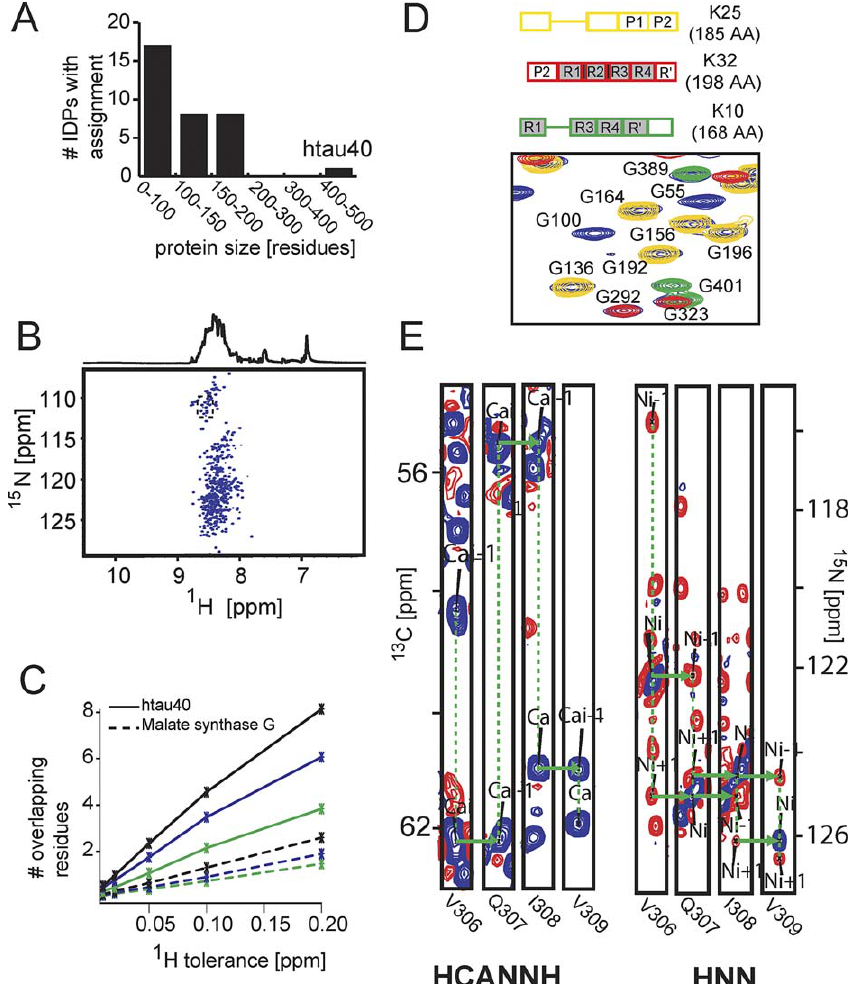
Figure 2. 441-Residue Tau at Single-Residue Resolution (A) Number of intrinsically disordered proteins with NMR backbone assignment. (B) 1 H- 15 N HSQC spectra of htau40 with 1 H projection on top. (C) Comparison of spectral overlap observed in HSQC spectra of htau40 (solid line) and 731-residue malate synthase G (dashed line). Black, blue, and green indicate 15 N chemical shift tolerances of 0.2, 0.15, and 0.1 ppm, respectively. (D) Superposition of a selected portion of the 1 H- 15 N HSQCs of the three tau fragments K25 (yellow), K32 (red), and K10 (green), and of 441-residue htau40 (blue). The domain organization of the three tau constructs is indicated. (E) Assignment strategy for htau40. 2-D strips of high-resolution 3-D HCANNH (left) and HNN spectra (right). The connectivity path linking residues V 306 to V 309 is marked in